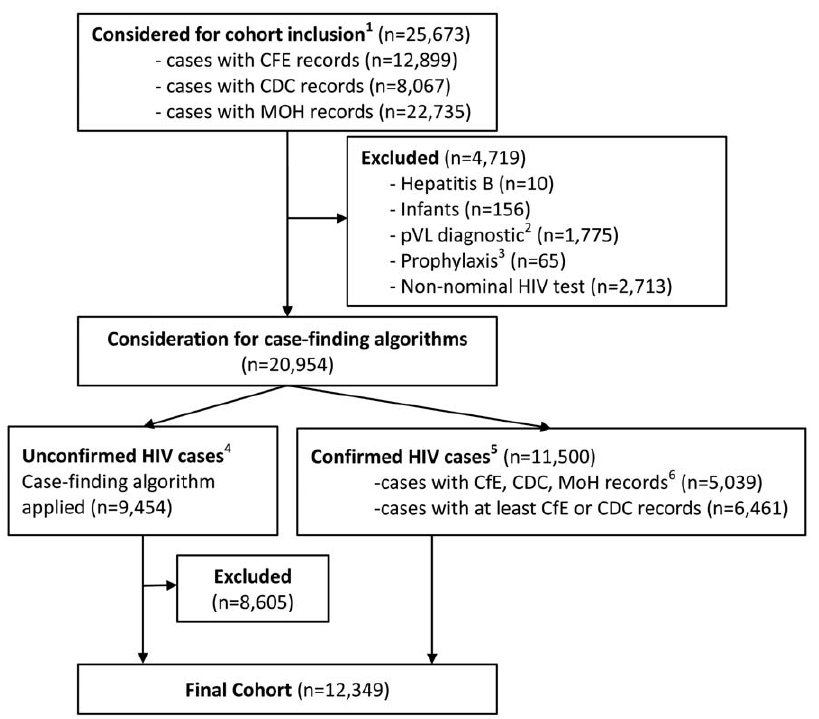
Figure 1. Flow diagram of the STOP HIV/AIDS cohort selection process. CDC: BC Centre for Disease Control; MoH: BC Ministry of Health Datasets (including Discharge Abstract Database, Medical Services Plan and PharmaNet databases); CfE: BC Centre for Excellence in HIV/AIDS. { identified with at least one record of the following: HIV positive test (CDC), HIV-related hospitalization or physician claim (MoH), pVL test, CD4 test, AIDS-defining illness or HAART dispensation (CfE). * Cases with one or more undetectable pVL tests, with no other HIV-related records. ** Identified with at least one HIV-related MoH record but no other HIV-related records in the CDC or CfE databases; *** Identified with confirmed positive HIV test, a pVL test with detectable viral load or antiretroviral